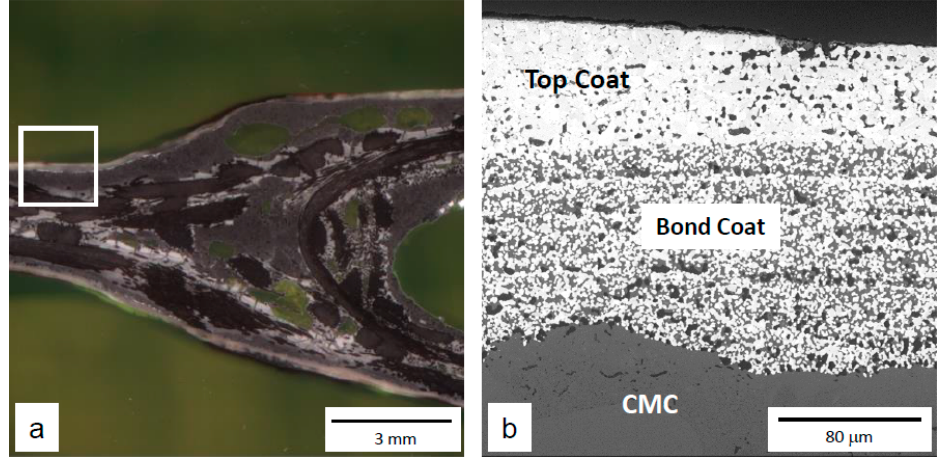
Figure 12. A cross-section near the trailing edge: ( a ) low magnification; ( b ) high magnification of the area marked with a square in ( a ).